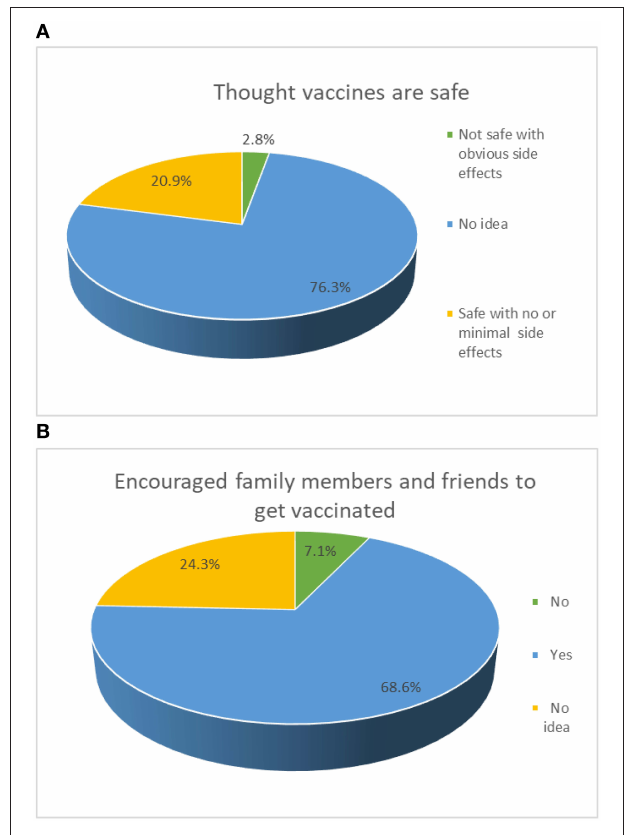
FIGURE 1 | Confidence in COVID-19